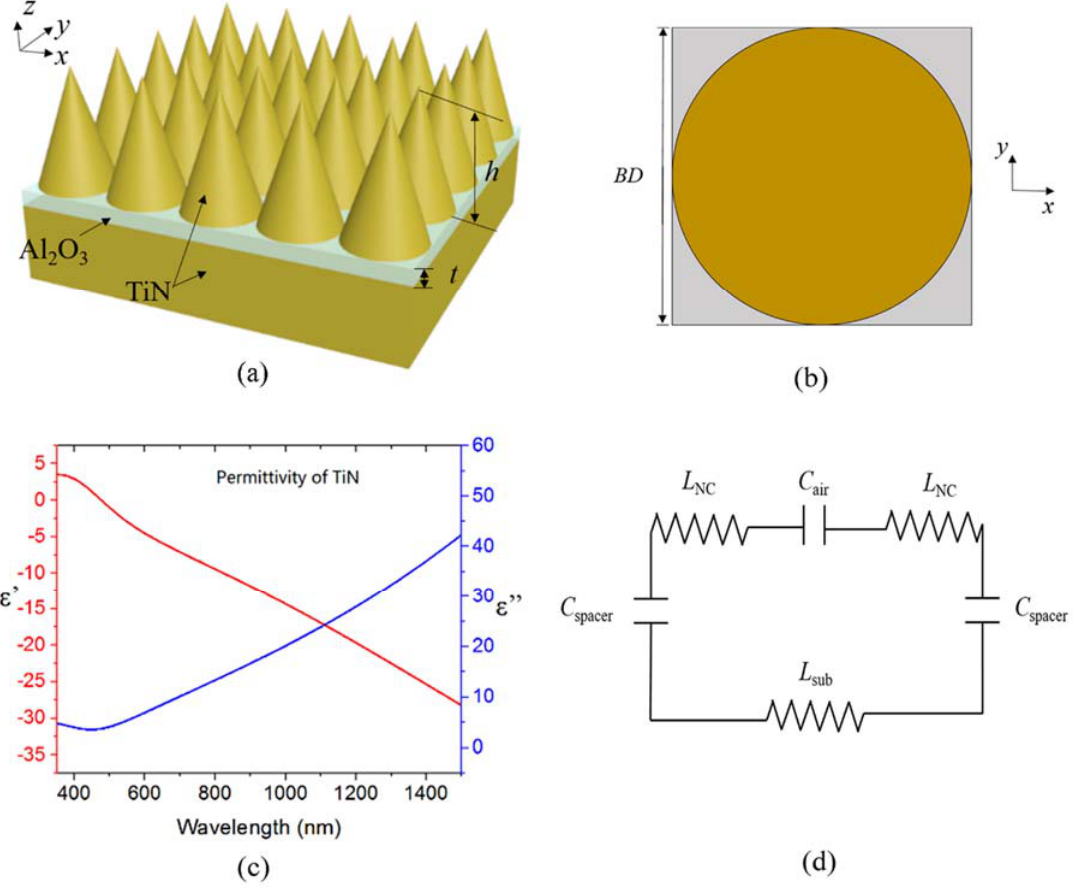
Figure 1. The schematic of the absorber ( a ) and top view of a unit cell ( b ); ( c ) The permittivity curves of TiN; ( d ) LC model of the proposed MPA.